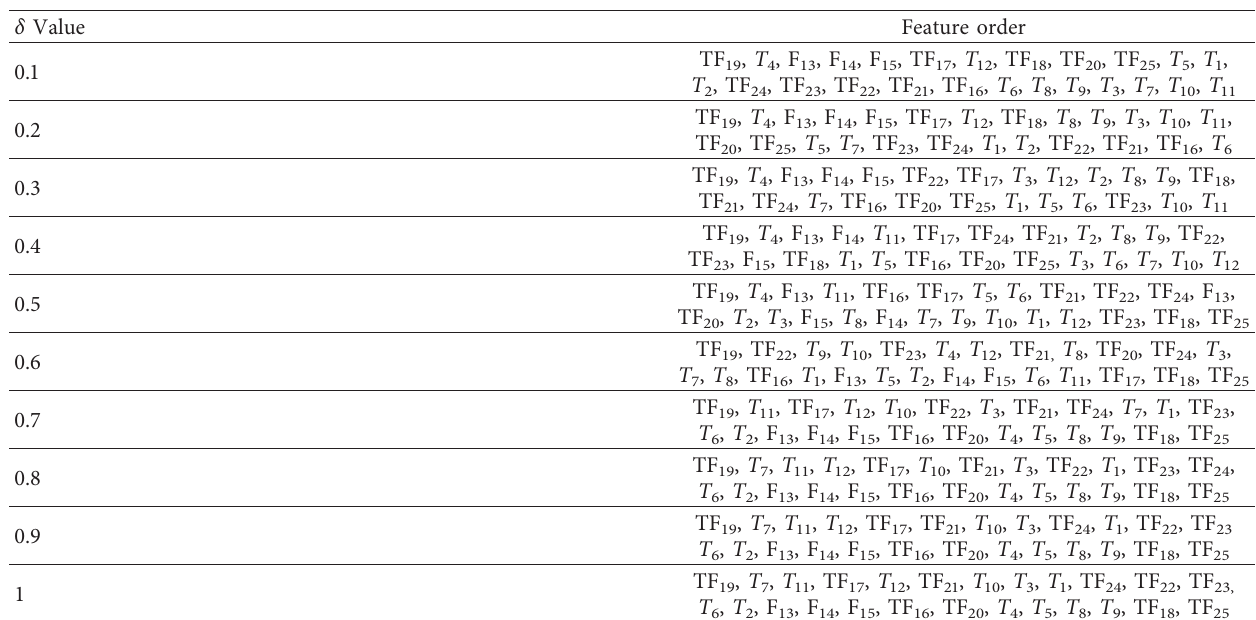
Table 3: Feature ranking.